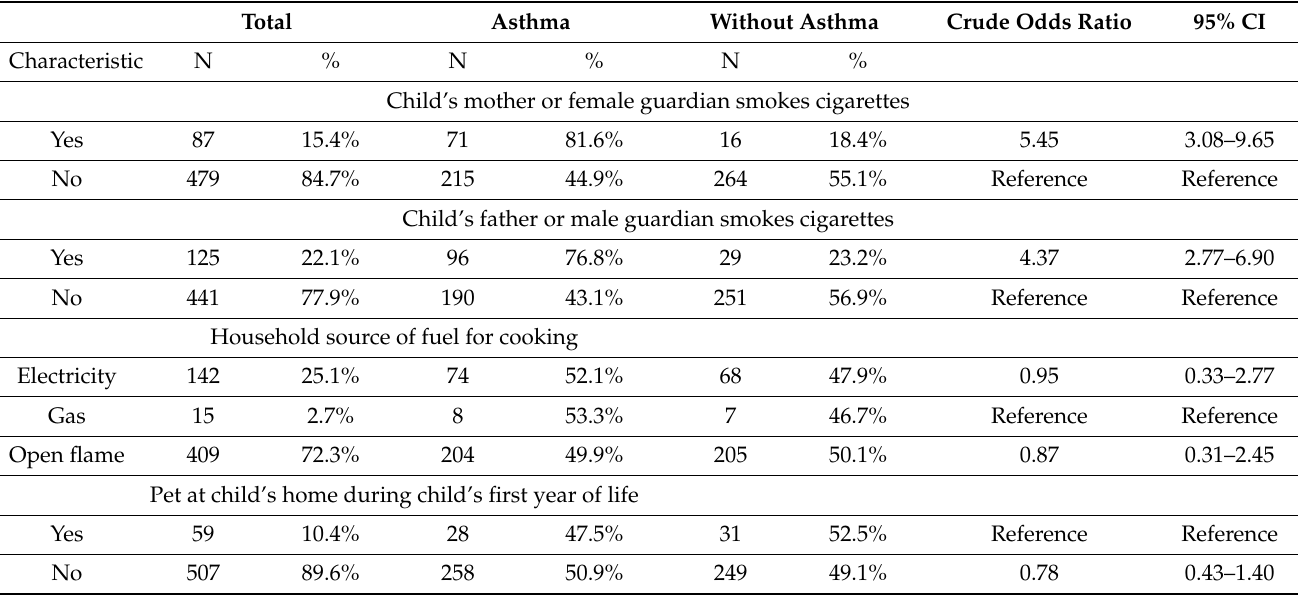
Table 4. Distribution and crude odds ratios of participants by asthma, indoor environmental tobacco smoke, and contact with animal.